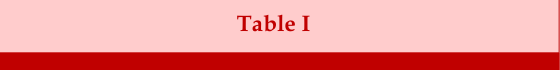
Composition of the essential oil of N.